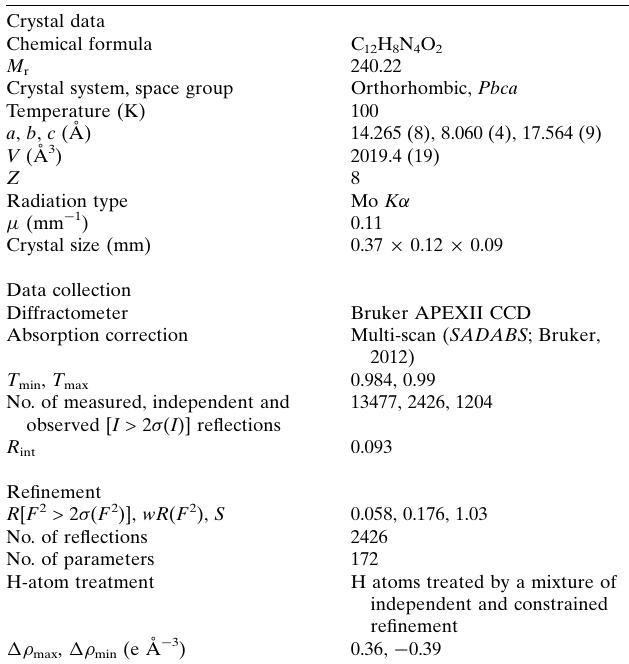
Table 2 Experimental